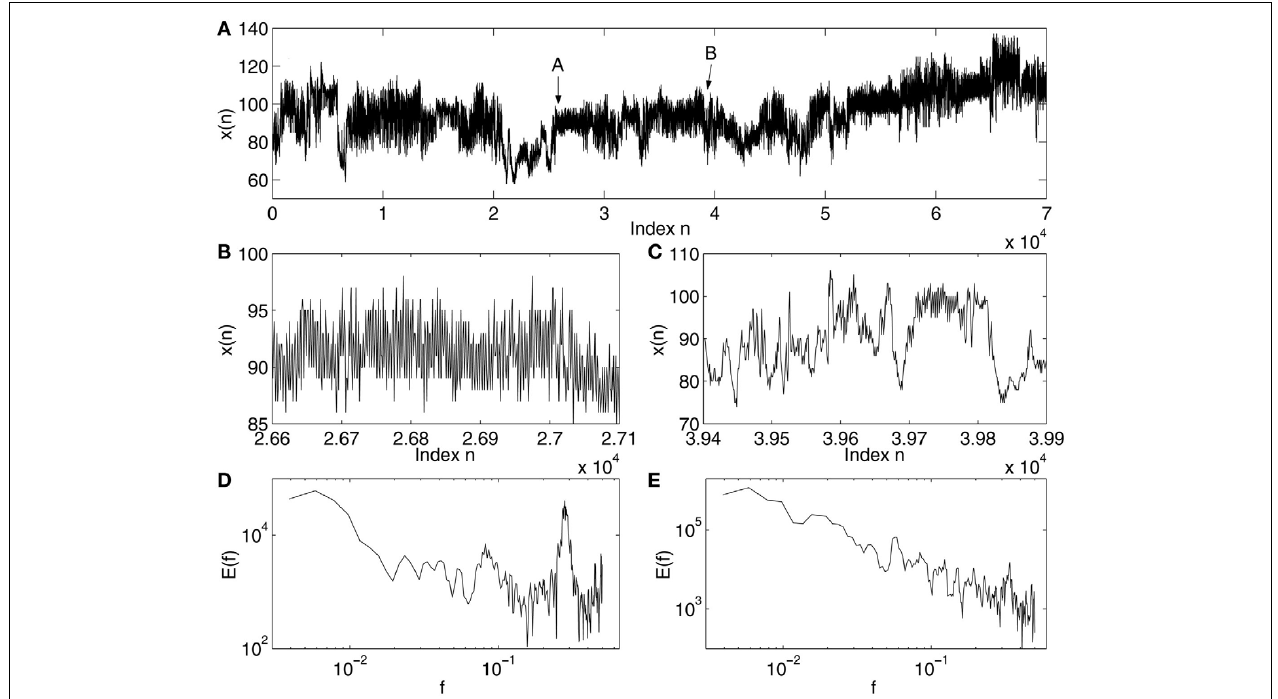
FIGURE 1 | Non-stationarity in HRV data: (A)The HRV data for a normal subject; (B,C) the segments of signals indicated asA and B in (A); (D,E) power spectral density E ( f ) vs. frequency f for the signals shown in